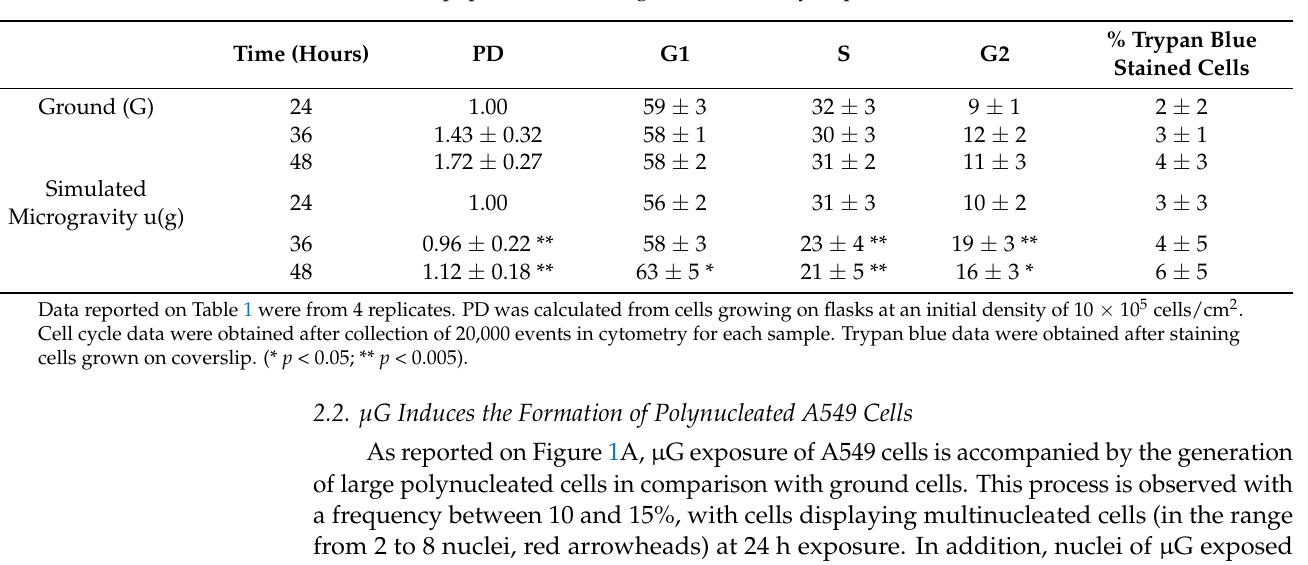
Table 1. Time course fluctuations in population doubling (PD) and cell cycle phases of A549 cells in NG and µ G. Time (Hours) PD G1 G2 Ground (G)